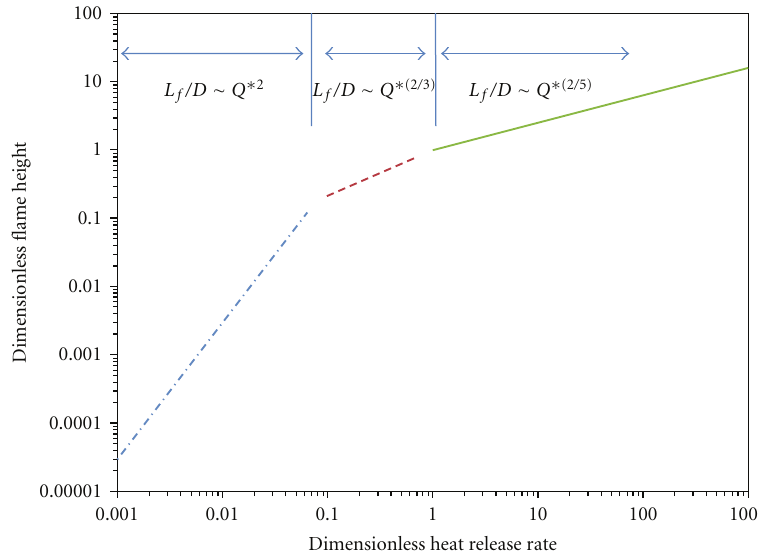
Figure 6: Dimensionless flame height ( L f /D ) correlations with dimensionless heat release rate ( Q ∗ )